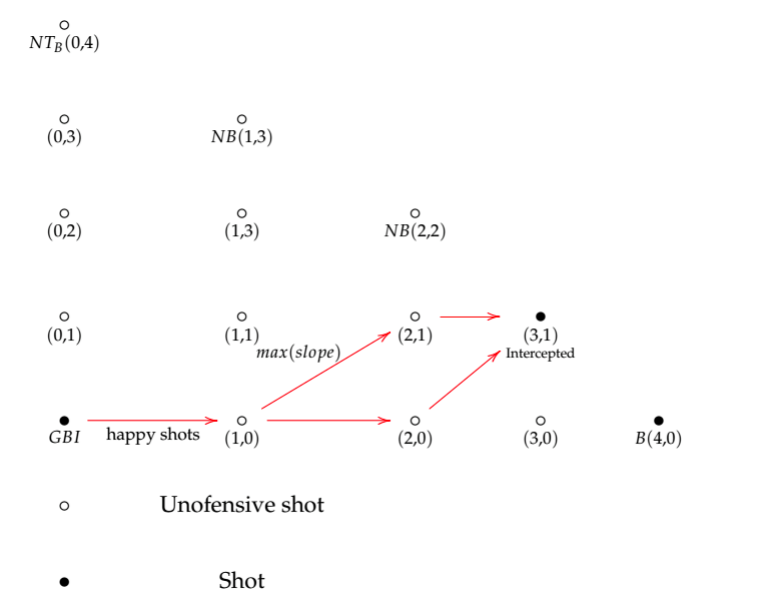
Figure 7. Example of a happy launch intercepting an adversary shot from point ( 4,0 )